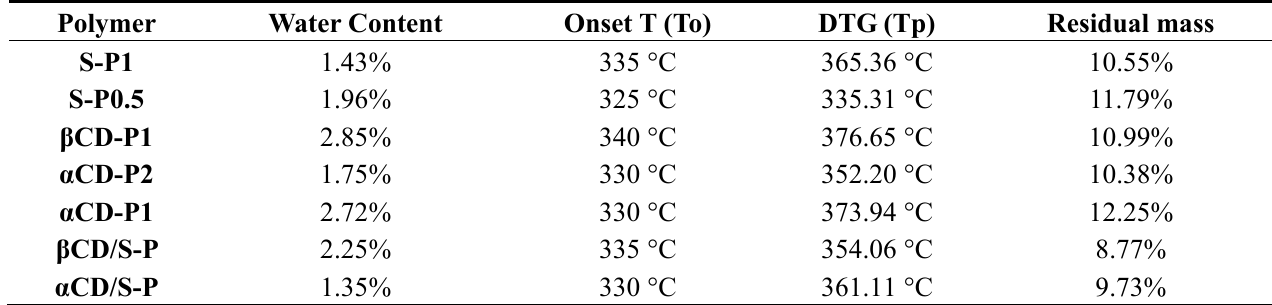
Table 2. Main features of DVS cross-linked homo- ( S-Pn and CD-Pn ) and hetero-polymers ( CDS/S-P ) calculated from the TGA analysis in a nitrogen atmosphere.